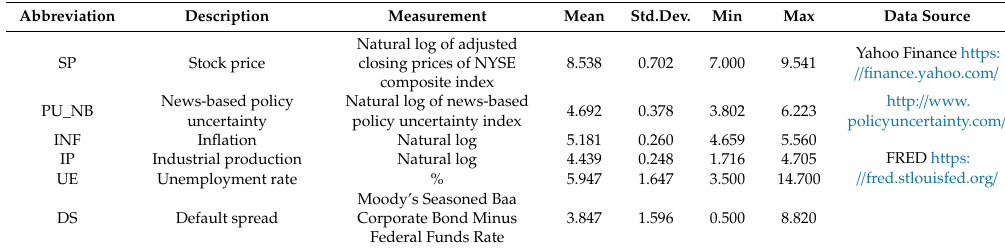
Table 1. Descriptive